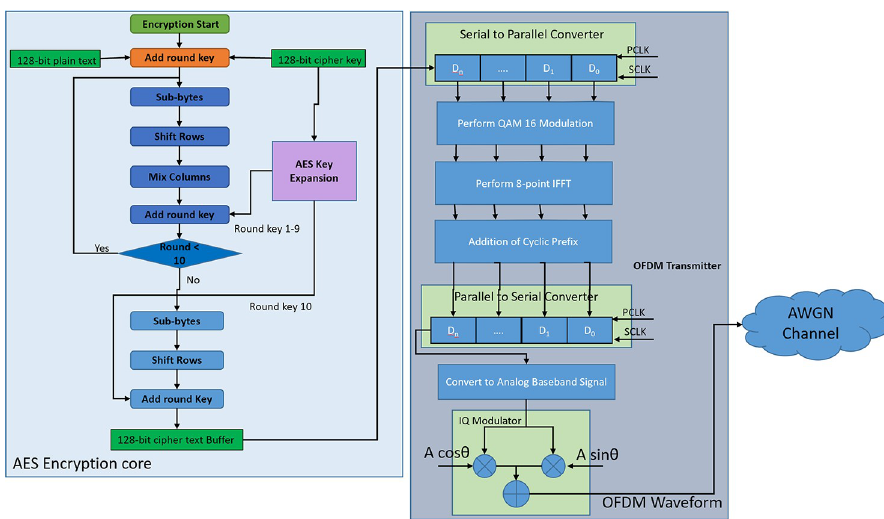
Fig 5. Flow chart of the AES based wireless transmitter